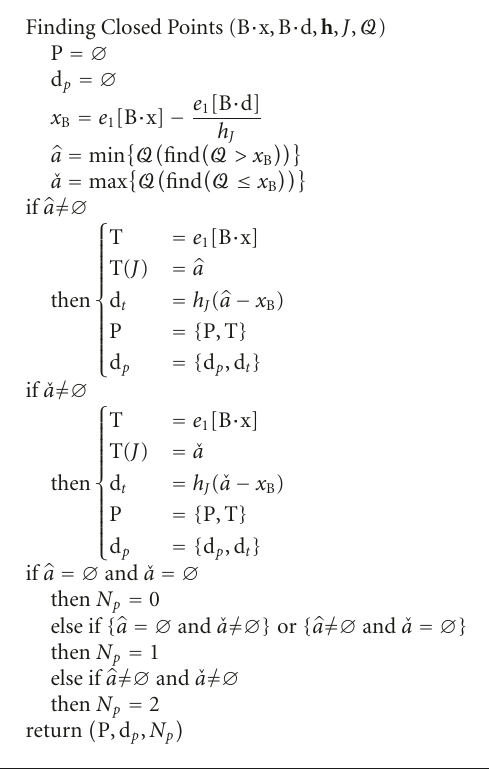
Algorithm 2: The pseudocode of the finding closed points algo- rithm.